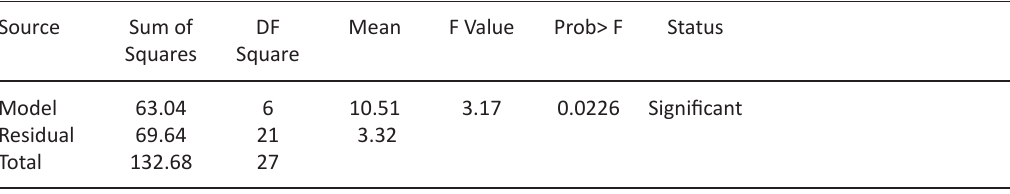
Table 7. ANOVA test for Response surface methodology-optimal